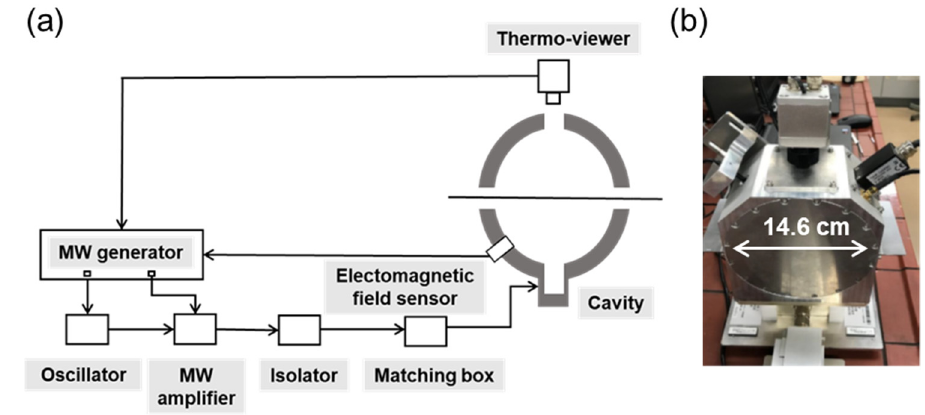
Figure 2. ( a ) Induction soldering system of microwave (MW) and ( b ) TM 110 single-mode